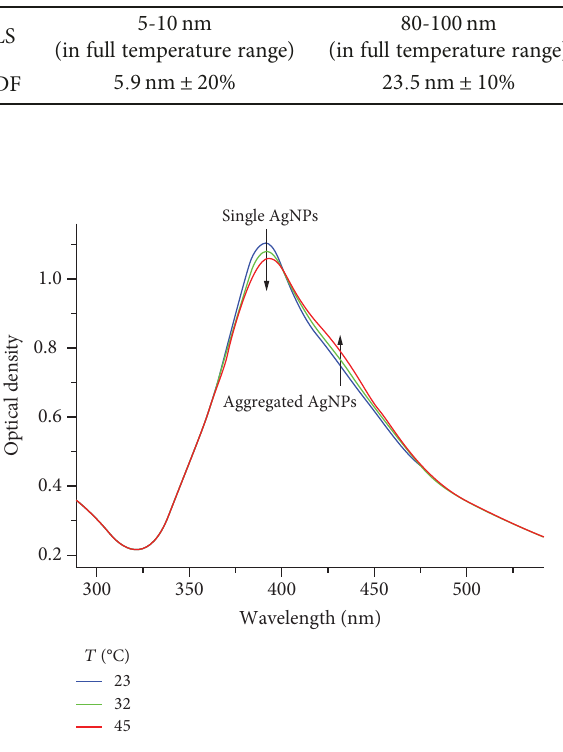
Figure 6: The behavior of the SPR absorption peak of AgNPs in the D70-g-PNIPAM/AgNP nanosystem at the increase of the temperature from 23 ° C to 45 °